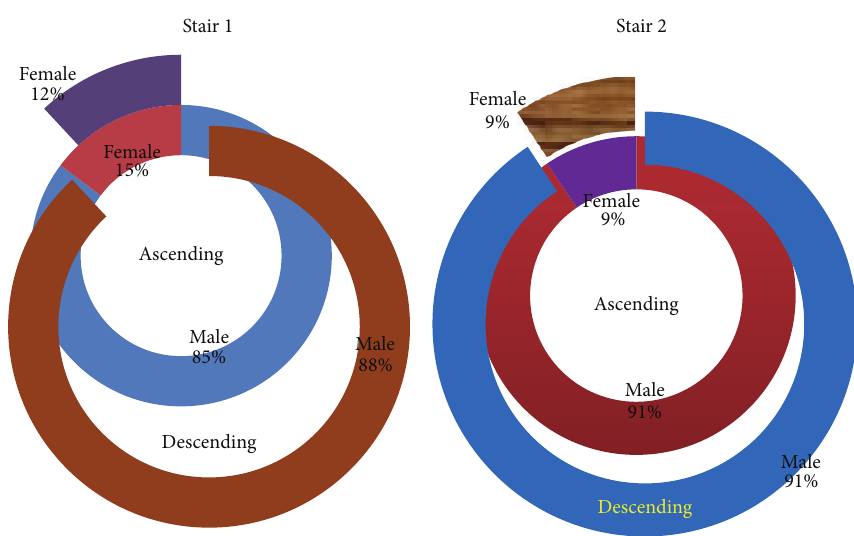
Figure 5: Genderwise distribution of pedestrian movement on both stairways.